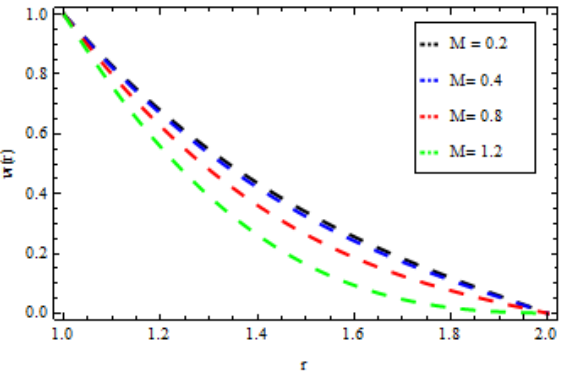
Figure 6. Velocity profile for various values of M when δ = 2, K = 0.1, β = 0.2.